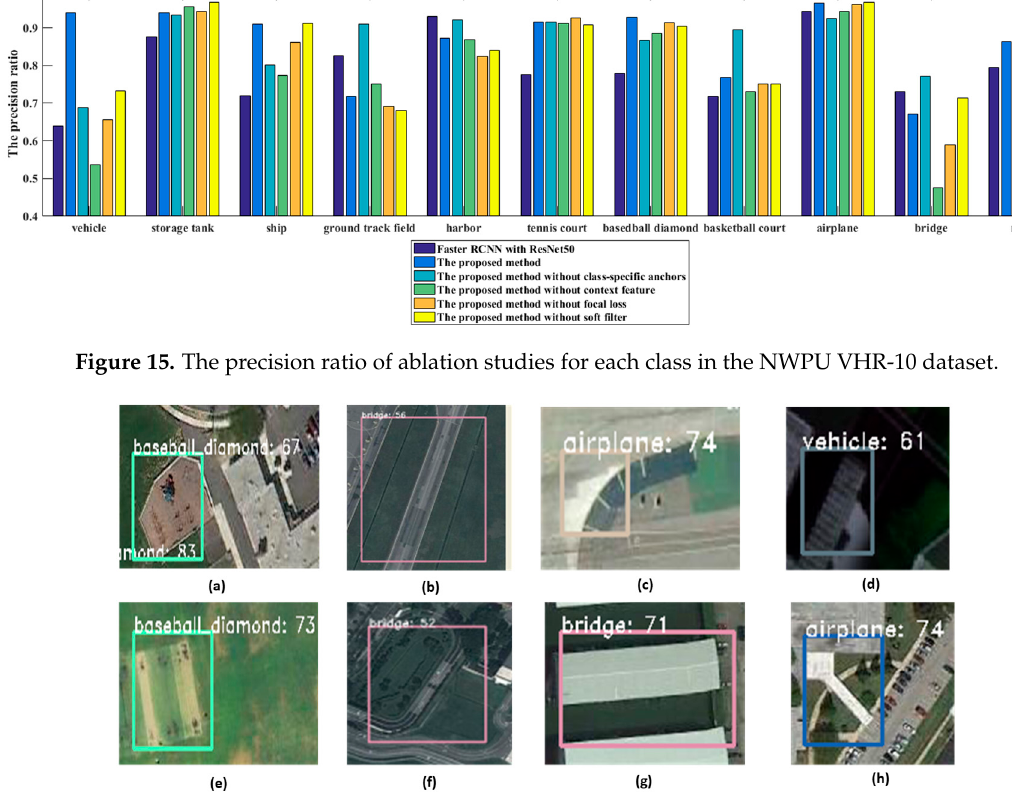
Figure 16. Some typical bounding boxes belonging to background that are falsely detected as objects in the CACMOD CNN without context information. ( a ) baseball diamond. ( b ) bridge. ( c ) airplane. ( d ) vehicle. ( e ) baseball diamond. ( f ) bridge. ( g ) bridge ( h ) airplane.